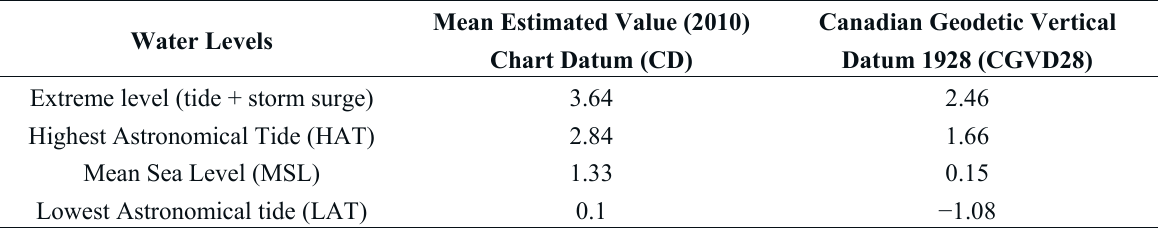
Figure 2. The beach of the study area is mainly natural on the eastern part ( a ) and characterized by a seawall on the western coastline ( b ). Table 1. Mean estimated tidal values in 2010 according to chart and geodetic datum, Belledune station (NB) (Canadian Hydrographic